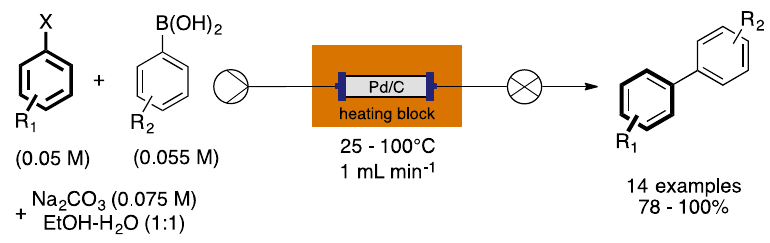
Figure 2. Substrate scope of continuous flow diazotization/iododediazotization/Suzuki–Miyaura cross-coupling sequence starting from aniline derivative.